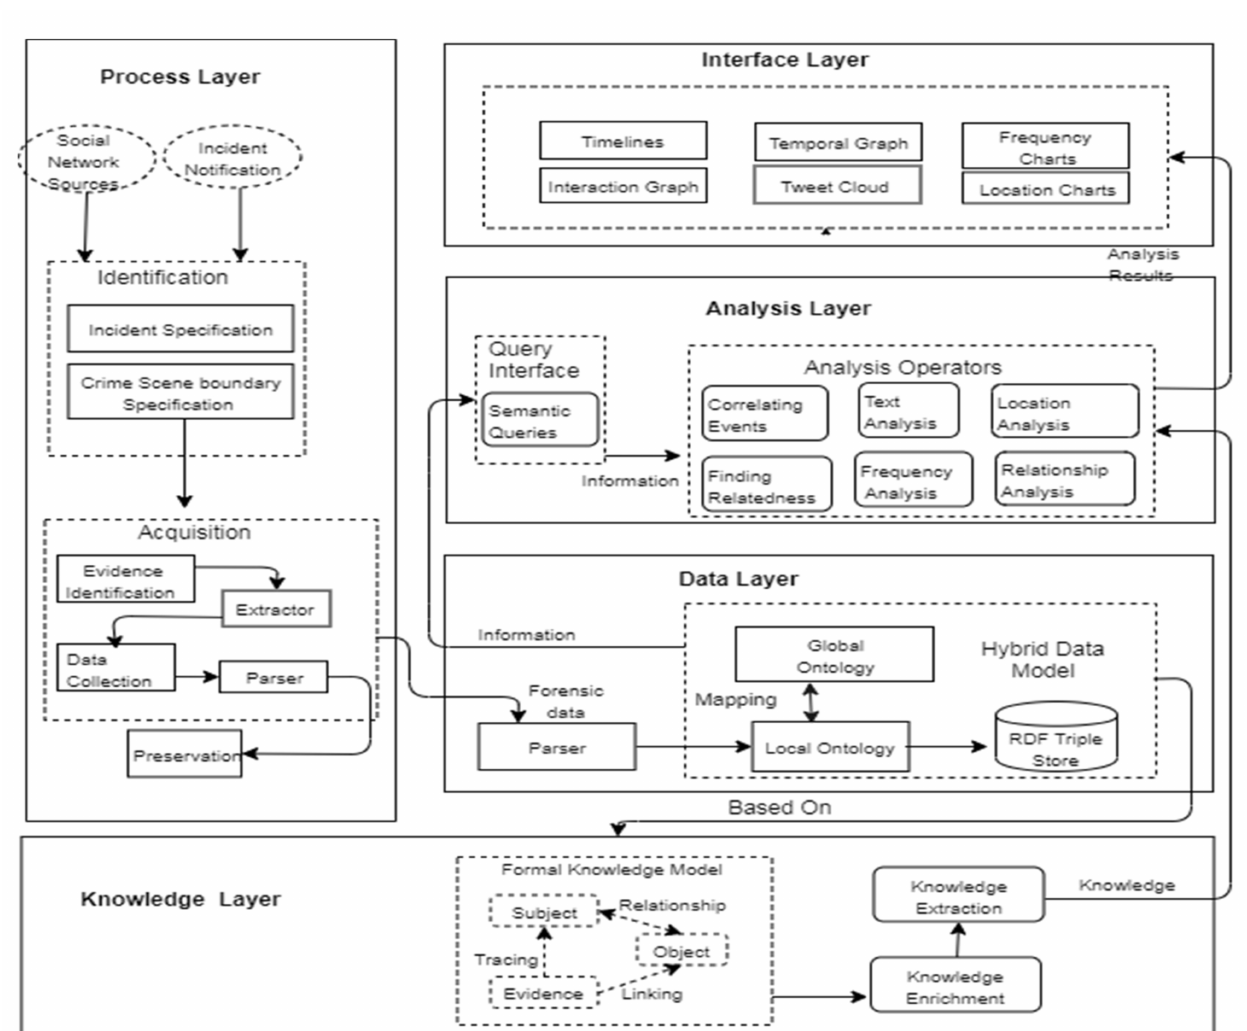
Figure 2. The architecture of the multi-layered